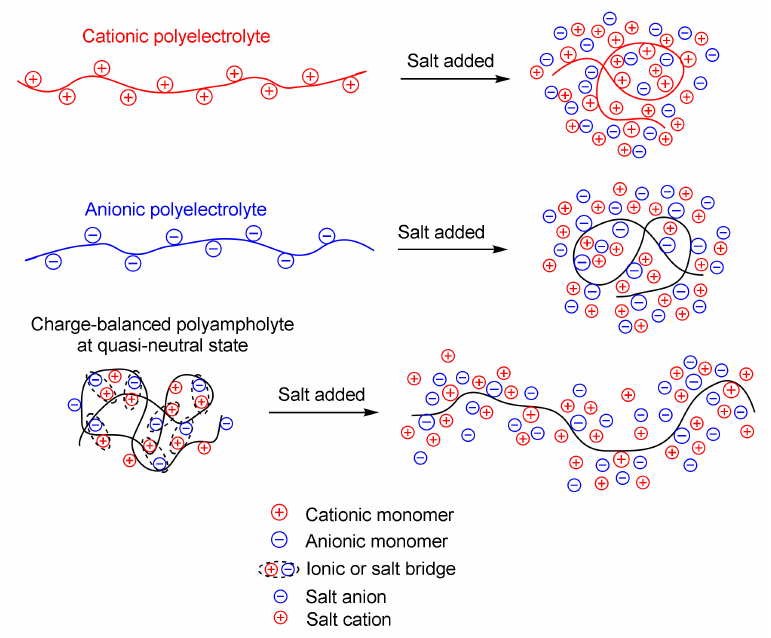
Figure 2. Illustration of the behavior of polyelectrolytes and polyampholytes in a salt solution. Reprinted with permission from Ref. [12]. 2021, Sarkyt E. Kudaibergenov